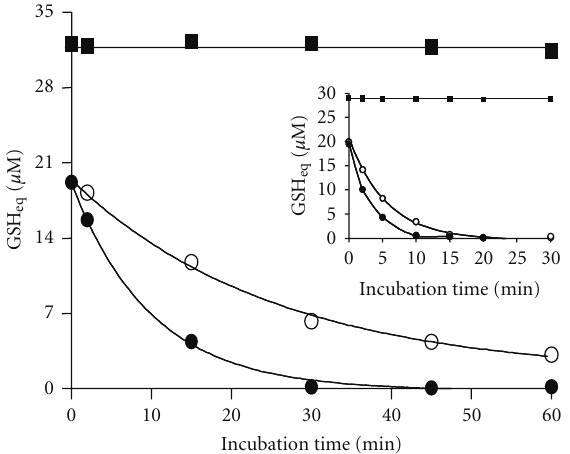
Figure 1: E ff ect of Tempol on thiol-titratable groups of the Cu(I)- [GSH] 2 complex. Tempol was added to a solution containing the Cu(I)-[GSH] 2 complex and the mixture incubated at 30 ◦ C for 0–60 min. Samples from such incubation were added DTNB (24 μ M) and the increase in OD 412nm registered 5 min later. Results are expressed as GSH equivalents ( μ M). The symbols represent: ( (cid:3) ) GSH (30 μ M); ( (cid:5) ) Cu(I)-[GSH] 2 (10 μ M); ( • ) Cu(I)-[GSH] 2 (10 μ M) plus Tempol (8 μ M). Insert to the figure shows results obtained from carrying out the same experiment but at 37 ◦ C, during 0–30 min.